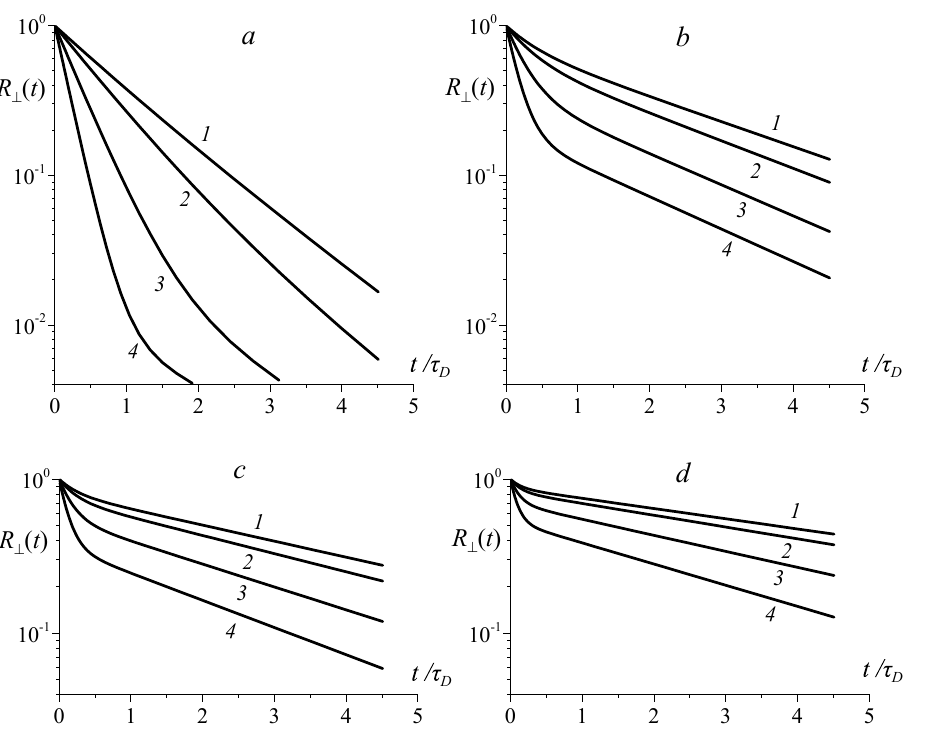
Figure 2. Relaxation functions for the “transverse” MRX; parameter κ = 2 × 10 3 ( a ); 100 ( b ); 40 ( c ); 20 ( d ); the non-dimensional bias field is ξ = 0.1( 1 ), 2 ( 2 ), 5 ( 3 ), 10 ( 4